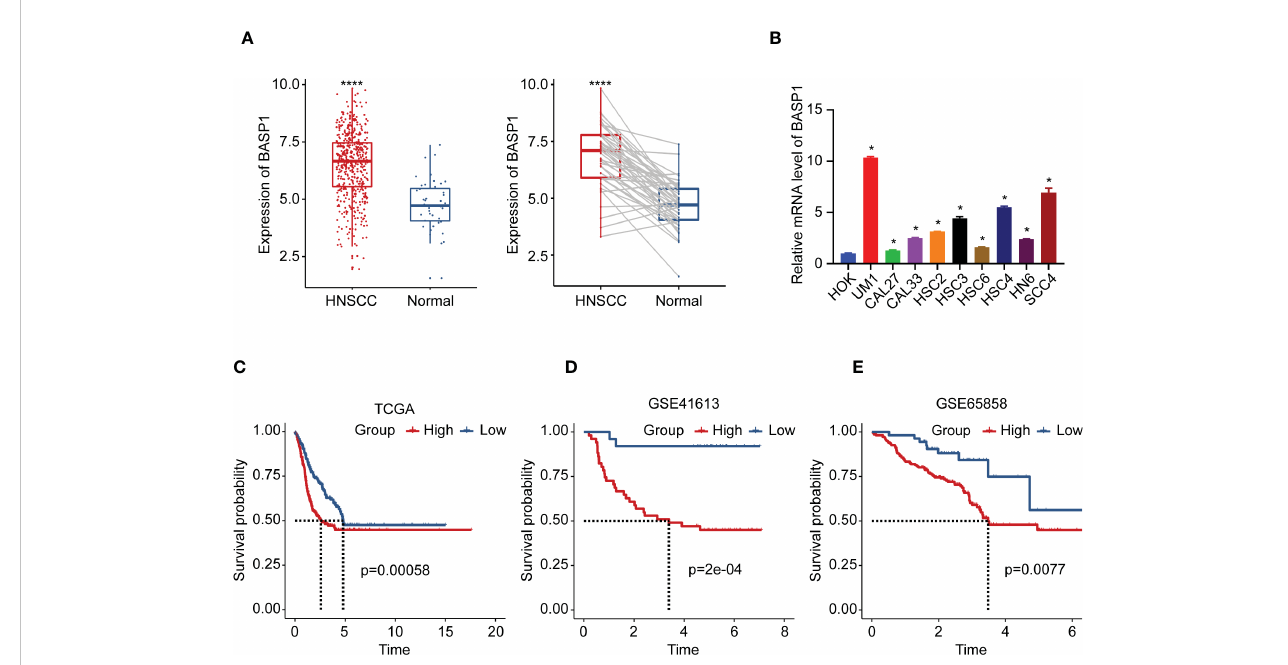
FIGURE 2 The expression and prognosis of BASP1 in HNSCC. (A) The box plot of BASP1 expressions between normal tissues and paired/unpaired HNSCC tissues. (B) The mRNA levels of BASP1 in HOK and HNSCC cell lines (UM1, CAL27, CAL33, HSC2, HSC3, HSC6, HSC4, HN6, and SCC4). (C-E) Kaplan-Meier survival curve of BASP1 in HNSCC from TCGA HNSC (C) , GSE41613 (D) , and GSE65858 (E) . * p < 0.05; **** p < 0.0001.